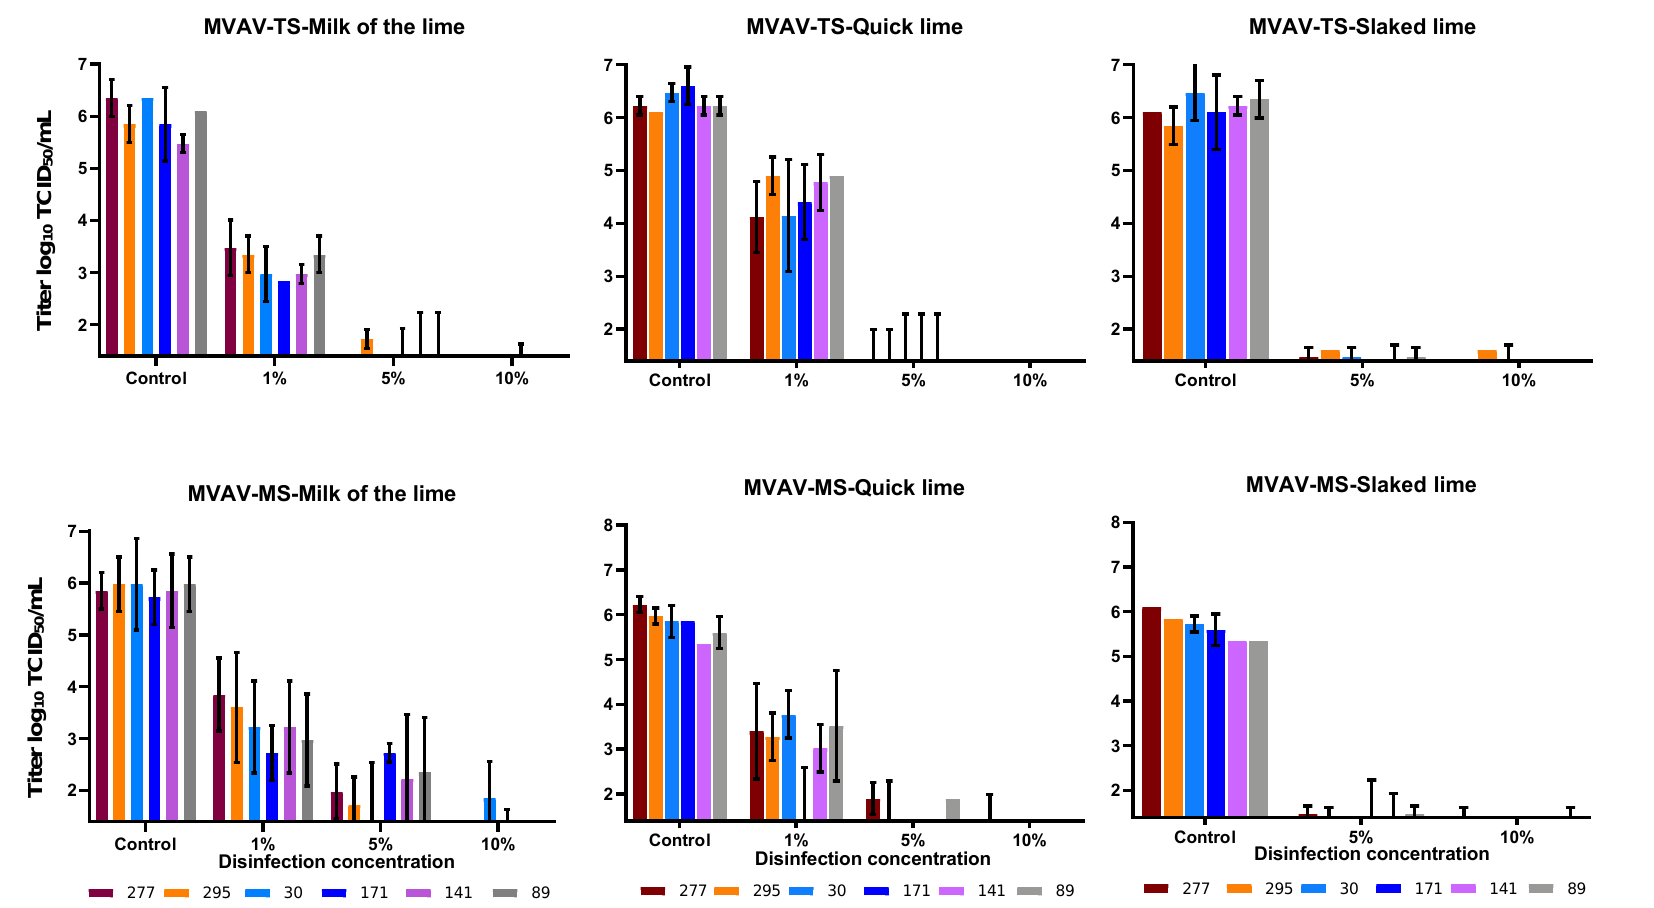
Figure 3. Comparison of the disinfection of MVAV with three different types of lime. Top three panels represent soil (TS) and lower three panels mineral soil (MS). The mean value and standard deviation of at least duplicate tests are shown. Virus titers were calculated by Spearman–Kaerber method. Limit of detection was 1.4 log 10 TCID 50 /mL.